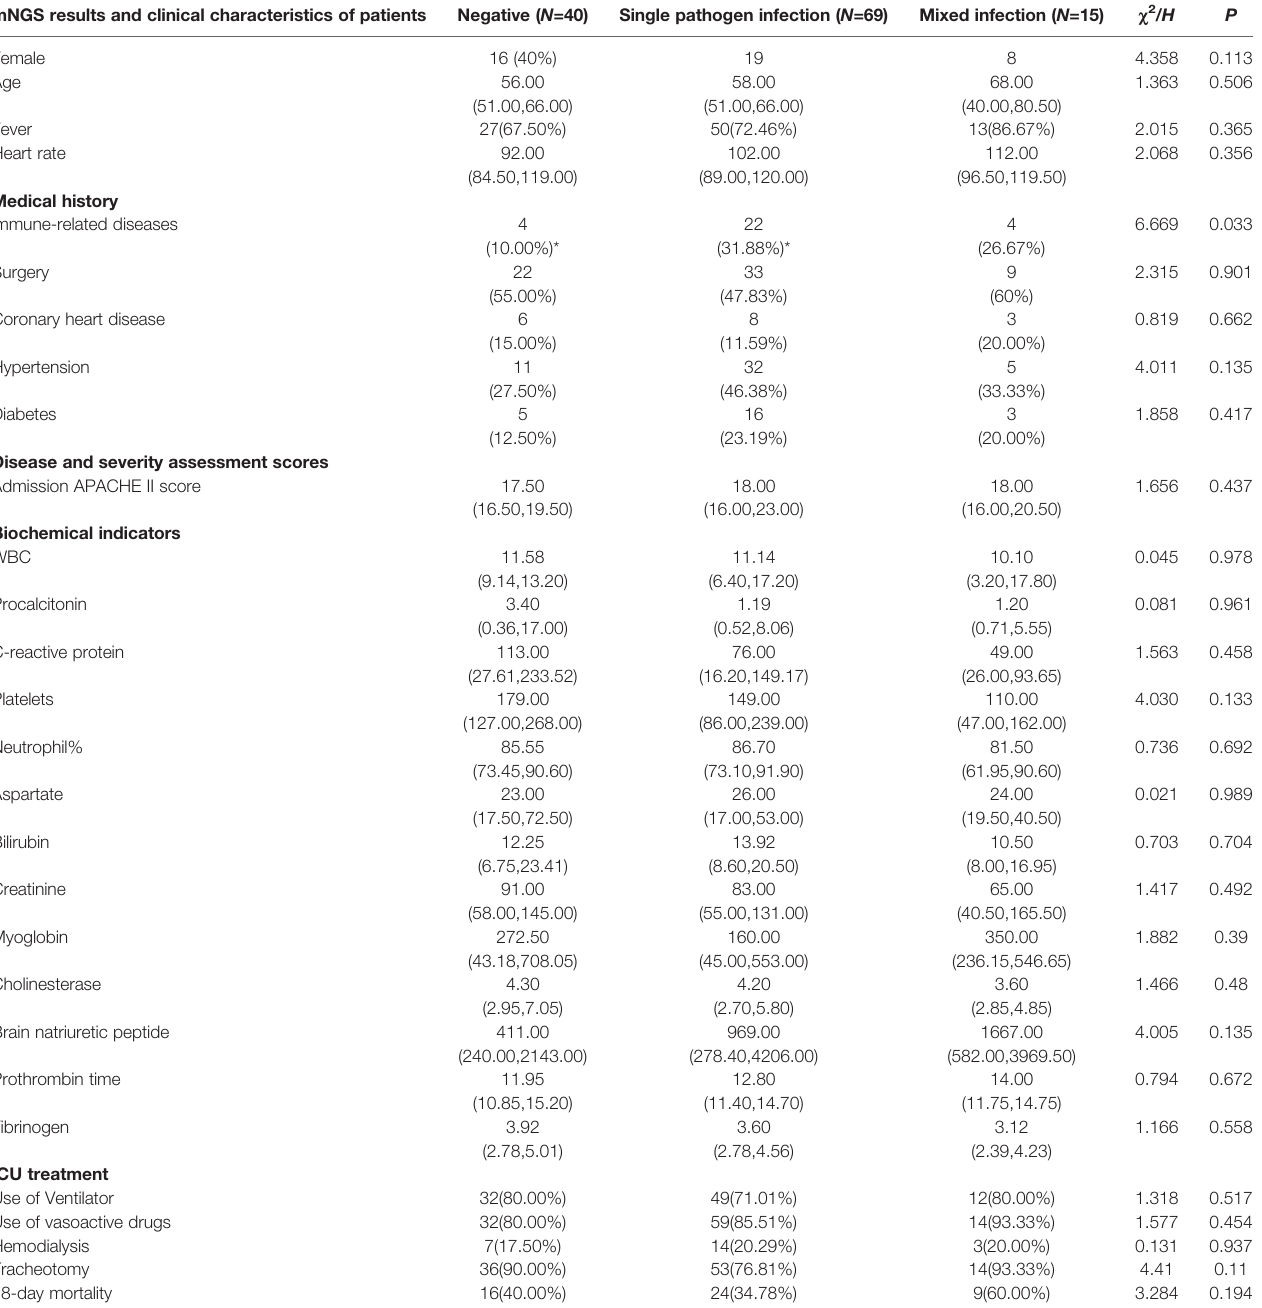
TABLE 2 | Comparison of negative mNGS results with positive mNGS results on the clinical characteristics of a single pathogen infection and a mixed infection. mNGS results and clinical characteristics of